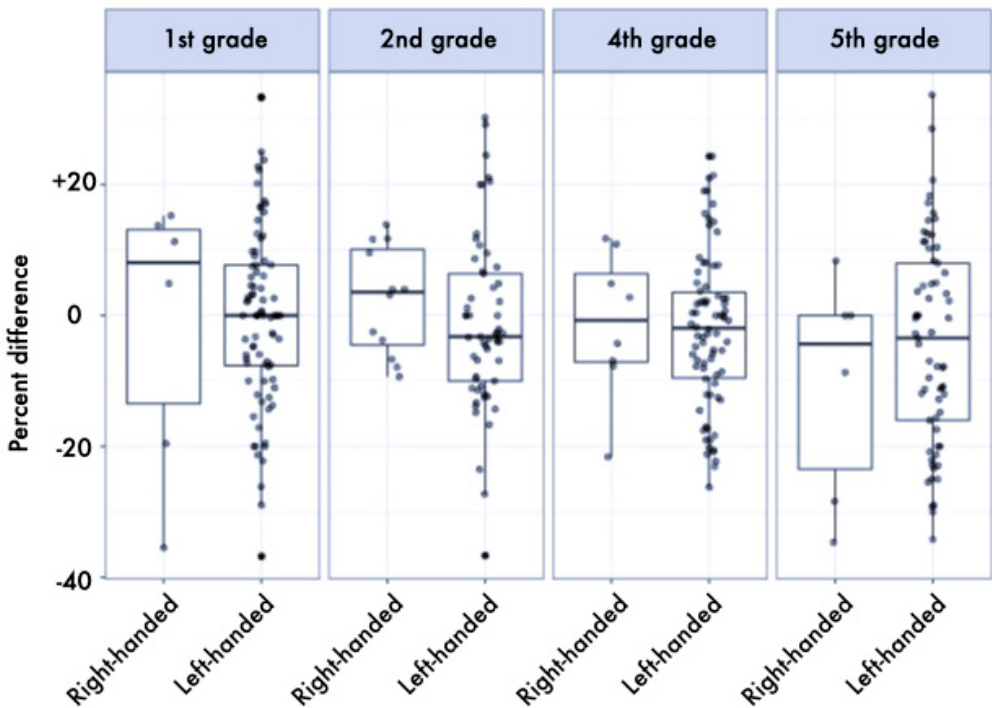
Figure 3. Boxplot (median and interquartile range, and individual values) of percent differences between dominant and non-dominant hand in the Thumb test stratified by school grade and hand preference. Values below 0% indicate better performance of the dominant hand. The median of the asymmetry index in favor of the dominant side was 1.39% for left-handed and 2.56% for right-handed individuals. Table 4 shows the correlation results: according to the absolute criteria [51], the three manual tasks